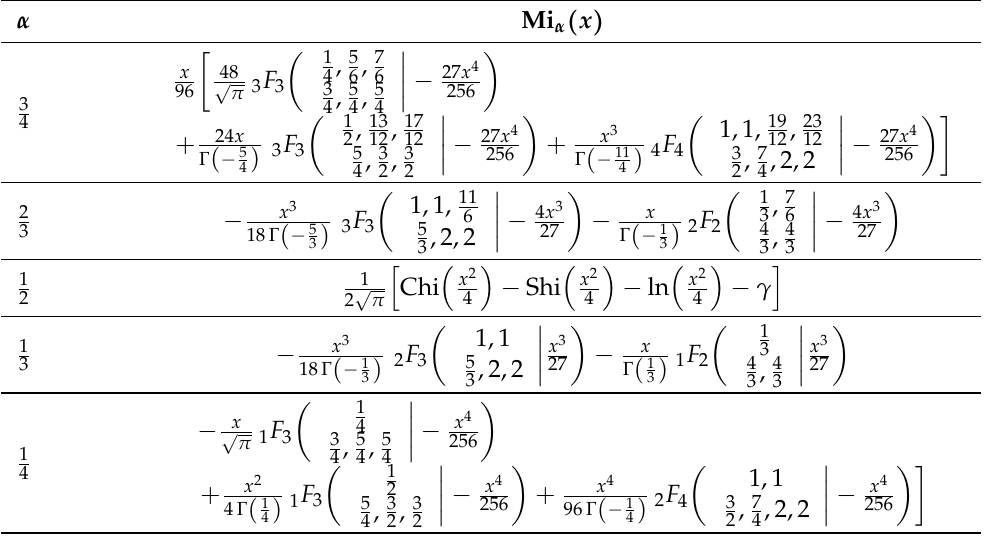
Table 13. The integral Mainardi function Mi α derived for some values of parameter α by using (45). α Mi α ( x